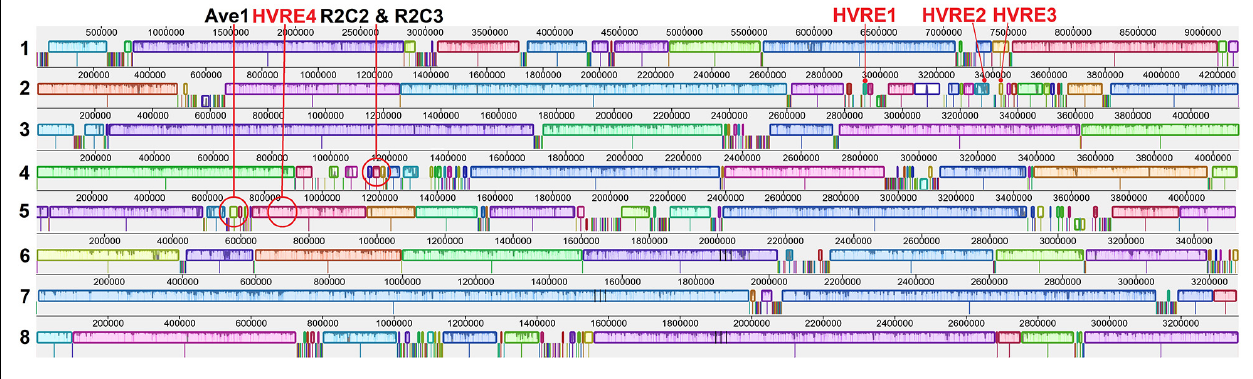
FIGURE 4 | Mauve alignments of chromosomes 1–8 of JR2 with 18 genomes included in this study. Locally collinear blocks (LCBs) and highly variable regions (HVRs) are displayed. Shown here are the 3 race specific (black text) and 4 other effectors (red text) present in these HVRs on chromosomes 2, 4, and 5. Different colors are used to differentiate